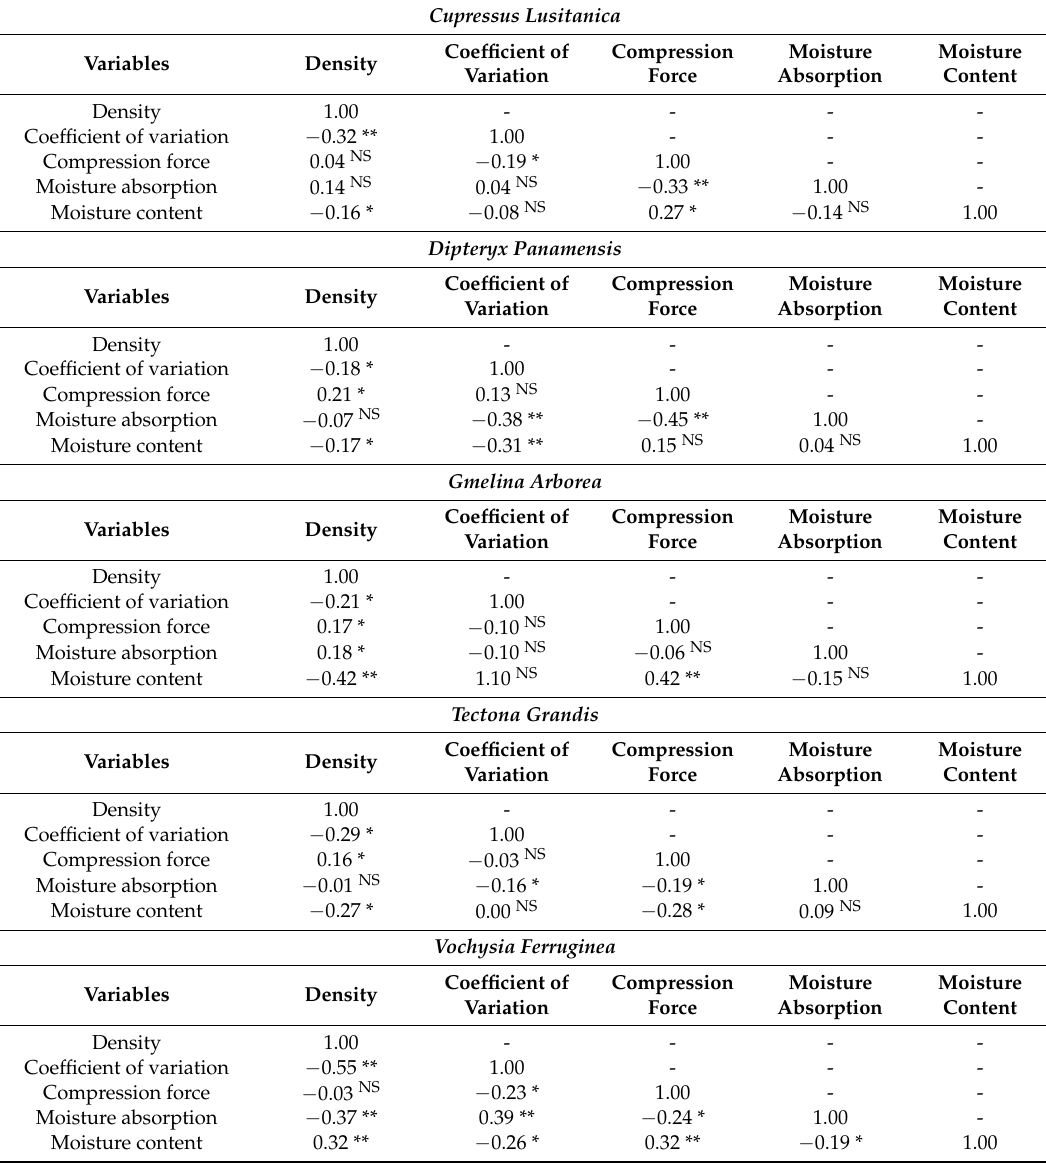
Table 2. Correlation matrix of the evaluated variables of torrefied pellets at different temperatures and times for five types of biomass from woody tropical